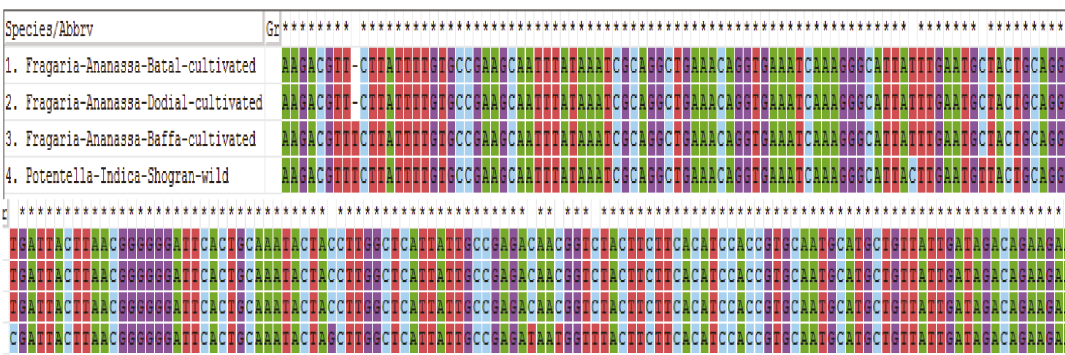
Figure 3: Alignment of Fragaria species of the rbclC